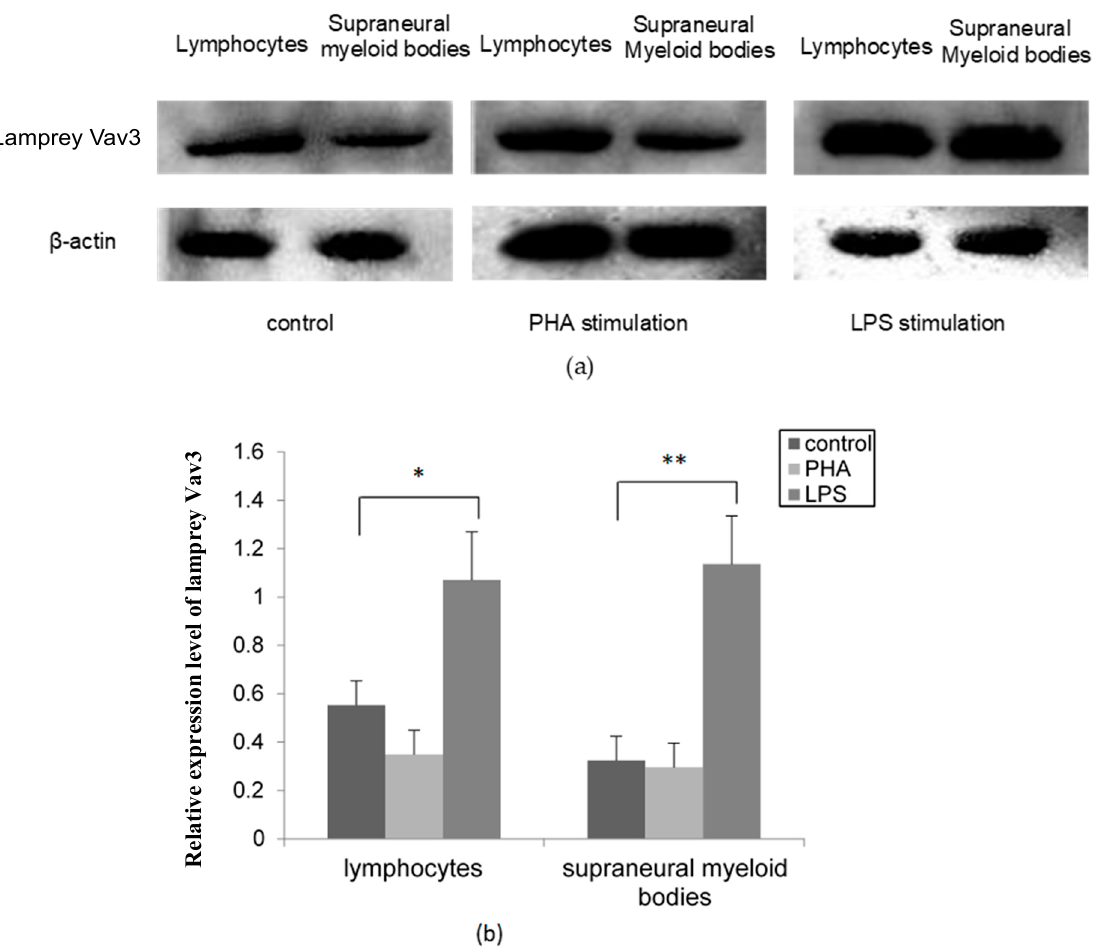
Figure 6. The expression property of lamprey Vav3 in response to the stimulation of lipopolysaccharide or phytohemagglutinin. Two groups of animals were stimulated with lipopolysaccharide (LPS) or phytohemagglutinin (PHA). Lymphocytes and supraneural myeloid bodies were isolated from the animals stimulated with LPS, PHA or not for extracting total protein samples. ( a ) Western blotting analysis was used to detect the expression levels of lamprey Vav3 as described in Materials and Methods Section; ( b ) A column chart created using data from three independent Western blotting analysis results. Data are presented as mean ± S.D. The significant differences p < 0.05 or p < 0.01 are shown with asterisks * or **, respectively.